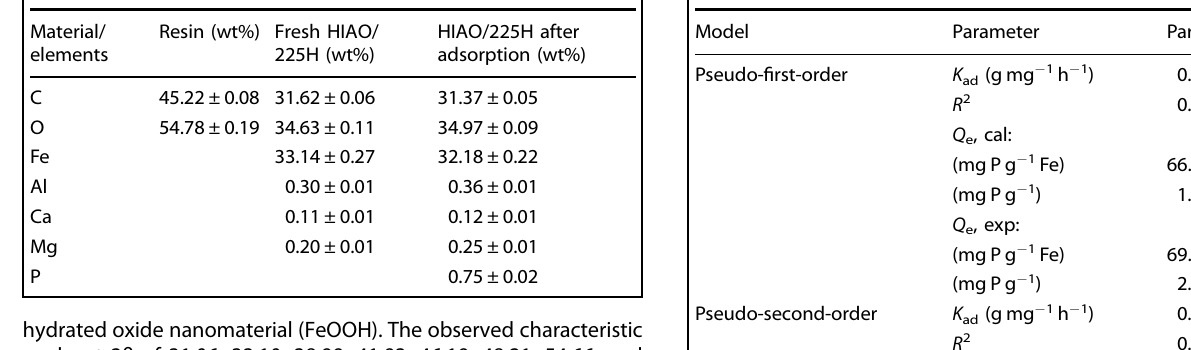
Table 2. The kinetic models for phosphate adsorption using HIAO/ 225H.